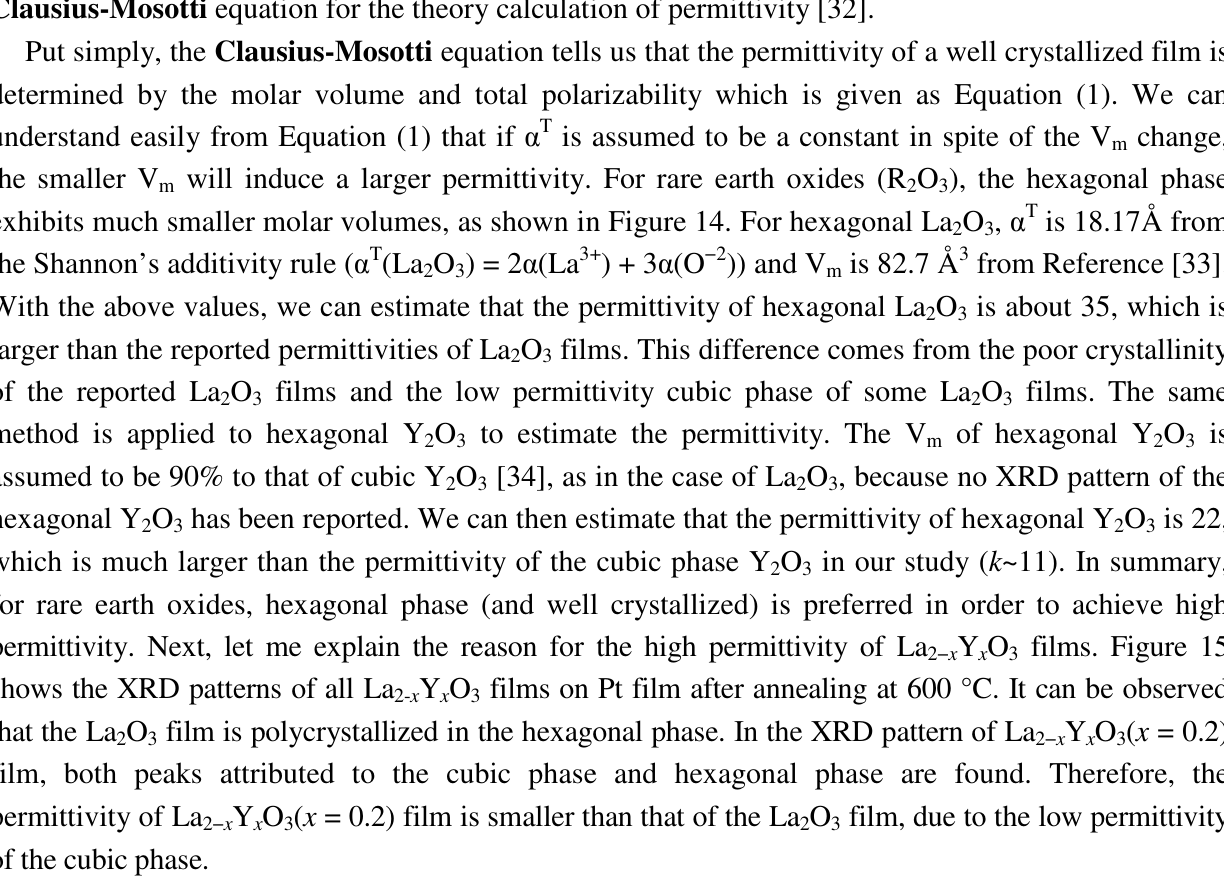
Figure 14. Molar volume comparison of hexagonal and cubic rare earth oxide (R